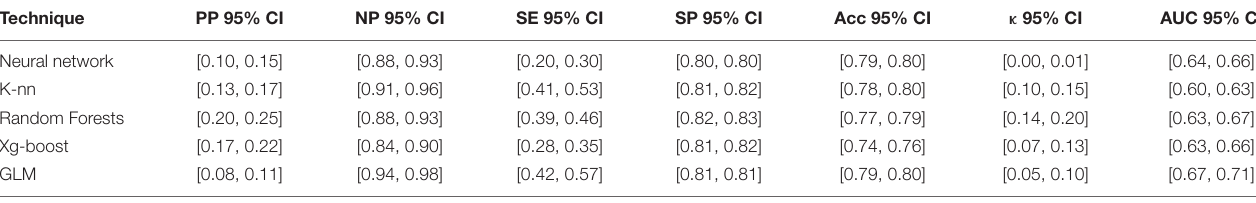
TABLE 9 | Confidence intervals of summary statistics for the predictive ability of the models built with five machine learning techniques in study 3a. Technique